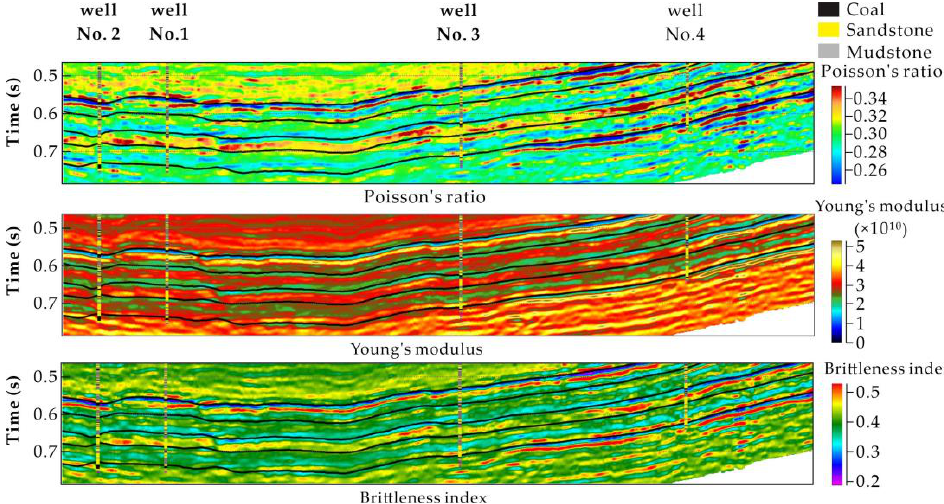
Figure 13. Profiles Poisson’s ratio, Young’s modulus, Brittleness index inversion.